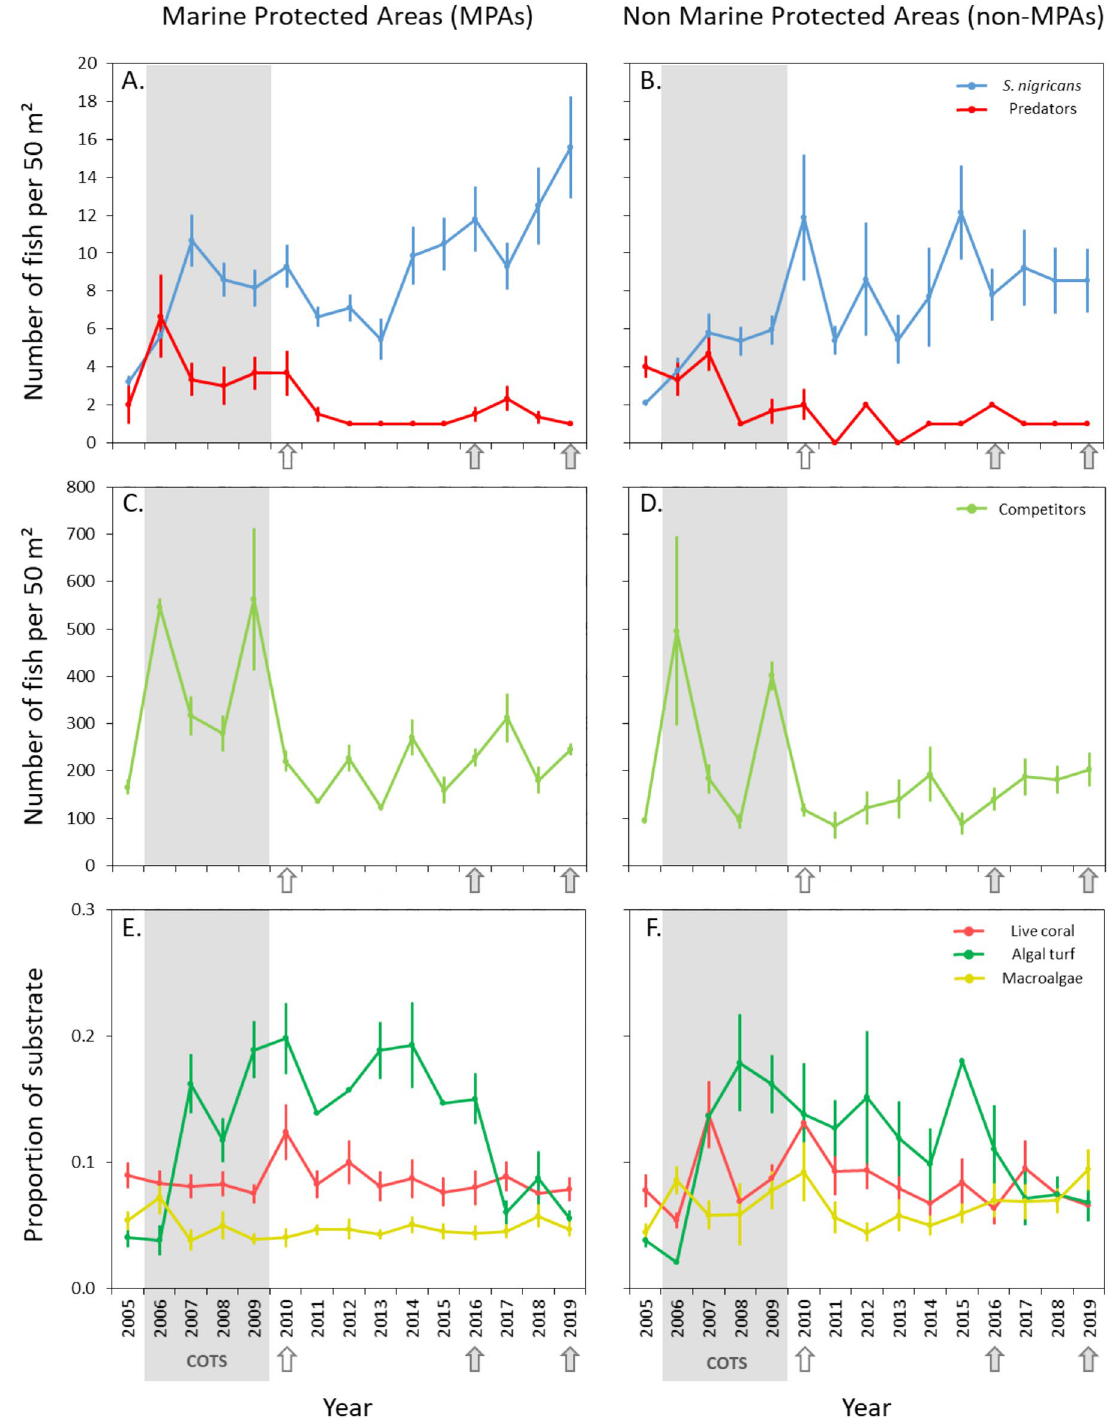
Figure 2. Number of fish per 50 m 2 of Stegastes nigricans and predators ( A , B ), competitors ( C , D ) and proportions of live coral, algal turf, and macroalgae ( E , F ) from 2005 to 2019 at Moorea on reef flats within no-take marine protected areas (MPA) and on non-protected sites (non-MPA), where fishing is allowed. Values are mean ± S.E. A COTS outbreak is indicated in grey (2006–2009), the 2010 hollow arrow indicates a cyclonic event (Cyclone Oli), and the filled arrows indicate weak bleaching events on the reef flats in 2016 and